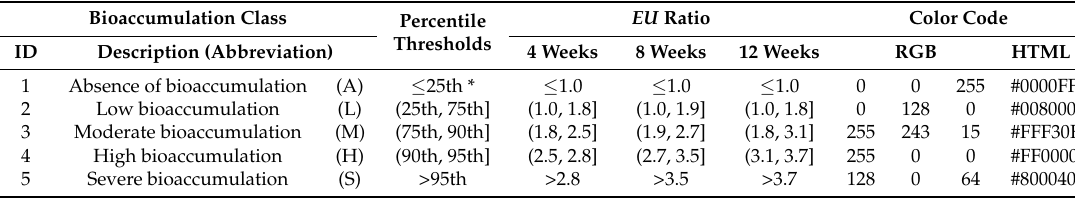
Table 5. EU ratio, percentile-based, five-class interpretative scale for bioaccumulation data from lichen transplants. Class codes, description and abbreviations, percentile thresholds, corresponding EU ratio values for different exposure time spans, and color codes (RGB and HTML) associated with bioaccumulation classes are